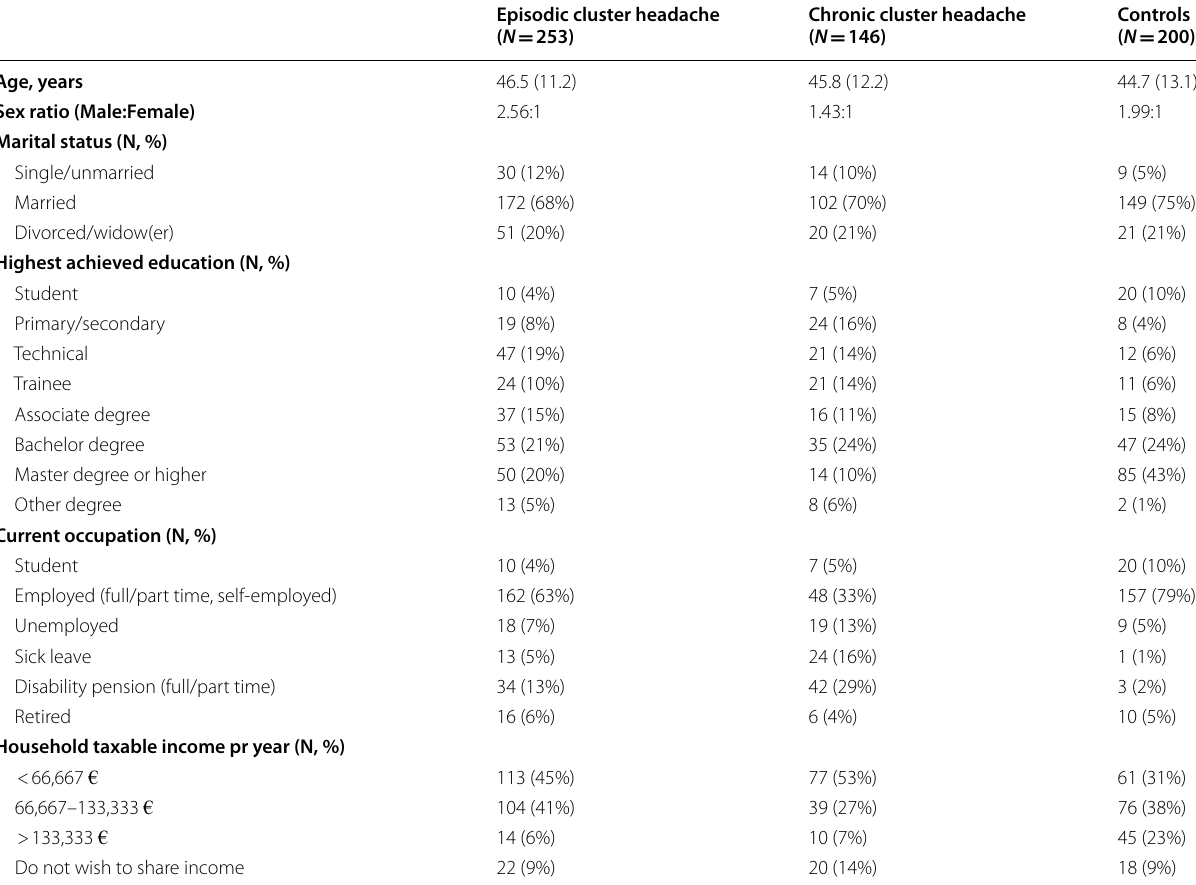
Data presented for 400 patients and 200 controls as means (SD) for numerical variables and as number (percentages) for categorical